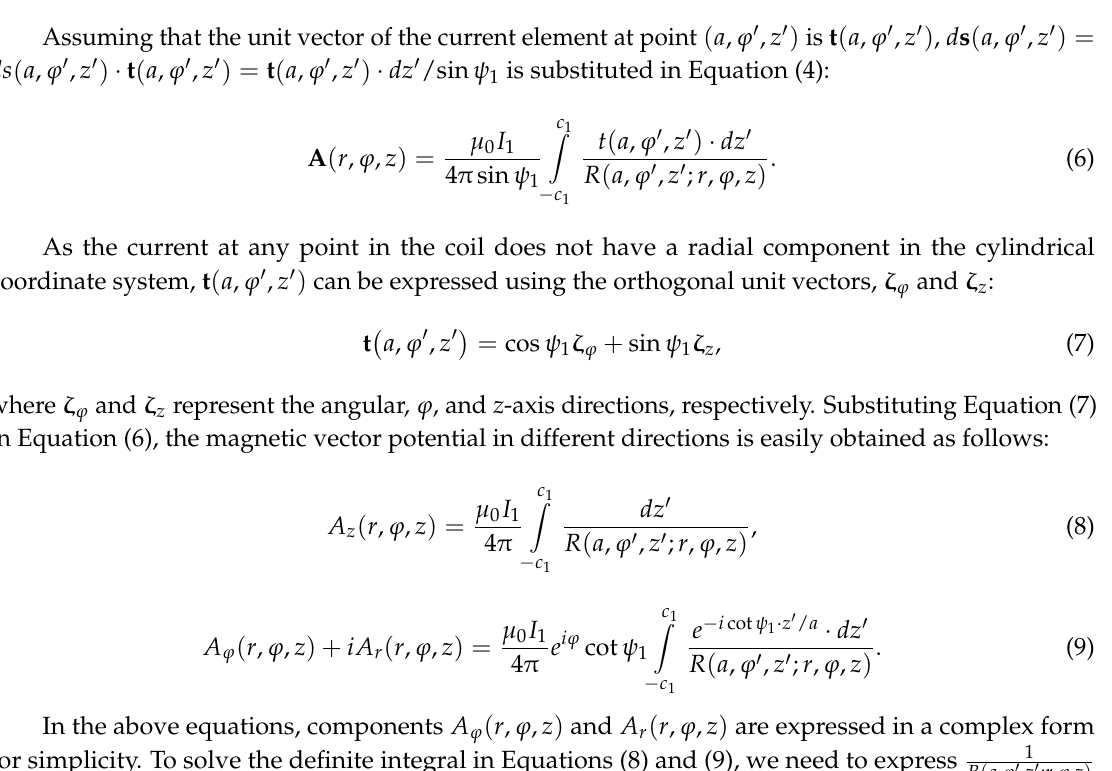
Figure 2. Mathematical model of finite-length coaxial helical filaments.